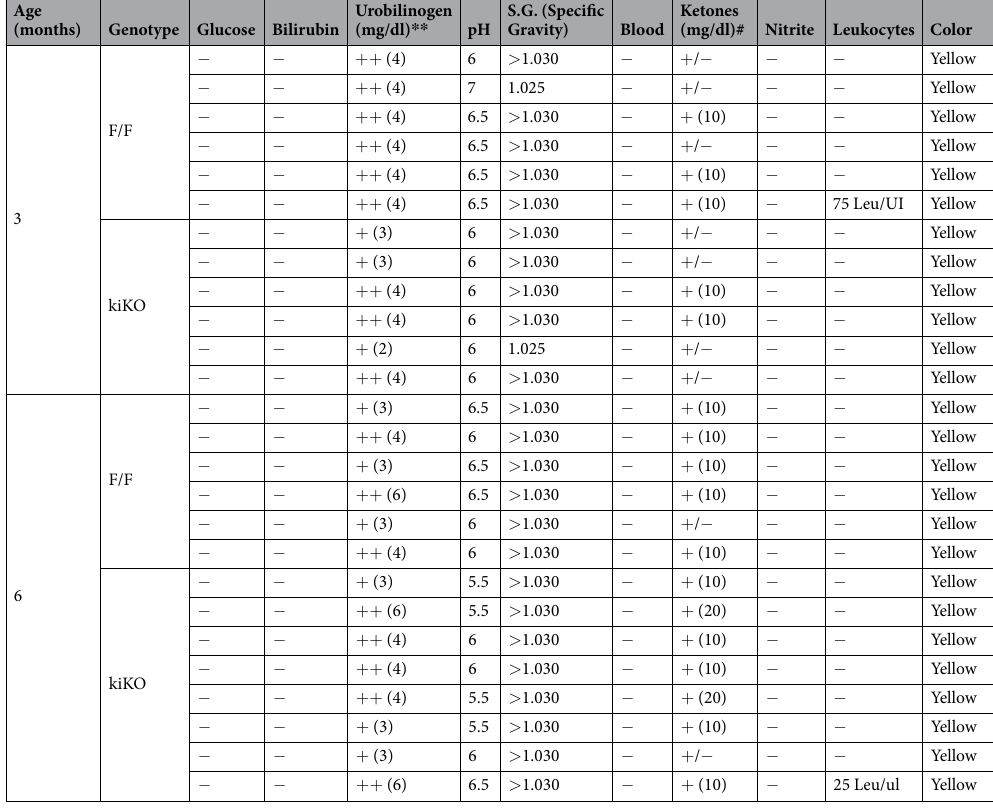
Table 1. Biochemical indices in urine of Rrm2b kiKO mice. ** Urobilinogen: 1 + , 2–3; 2 + , 4–6; 3 + , 8–12. #Ketones: ± , < 10; 1 + , 10–20; 2 + ,